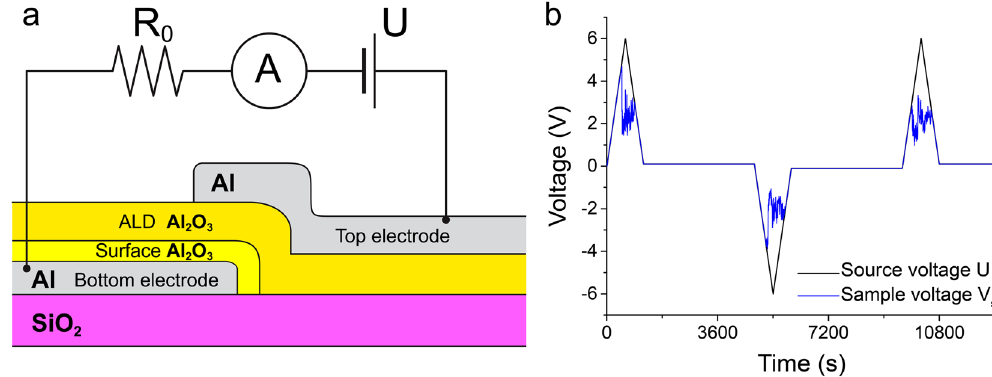
Figure 1. ( a ) Schematic of the sample (not to scale) and electrical diagram of the measurement setup. All the layers are labeled explicitly. The measurement setup includes electrometer Keithley 6517B serving as the voltage source and the ammeter, and the series resistor R 0 ≈ 10 MΩ. ( b ) An example of an electric breakdown measurement. Black line shows how the source voltage changes over time, the blue line depicts the corresponding voltage drop on the sample. The thickness of the insulating layer in this example was 4 nm. The sample voltage at first follows the source voltage. In this example, at voltage about 5 V dielectric breakdown happens. The sample resistance gets reduced by orders of magnitude, thus the voltage on the capacitor (blue curve) also